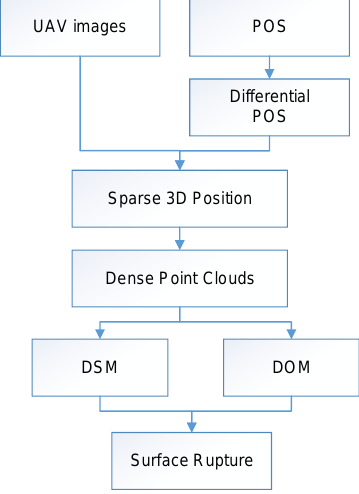
Figure 3. UAV images processing Flow